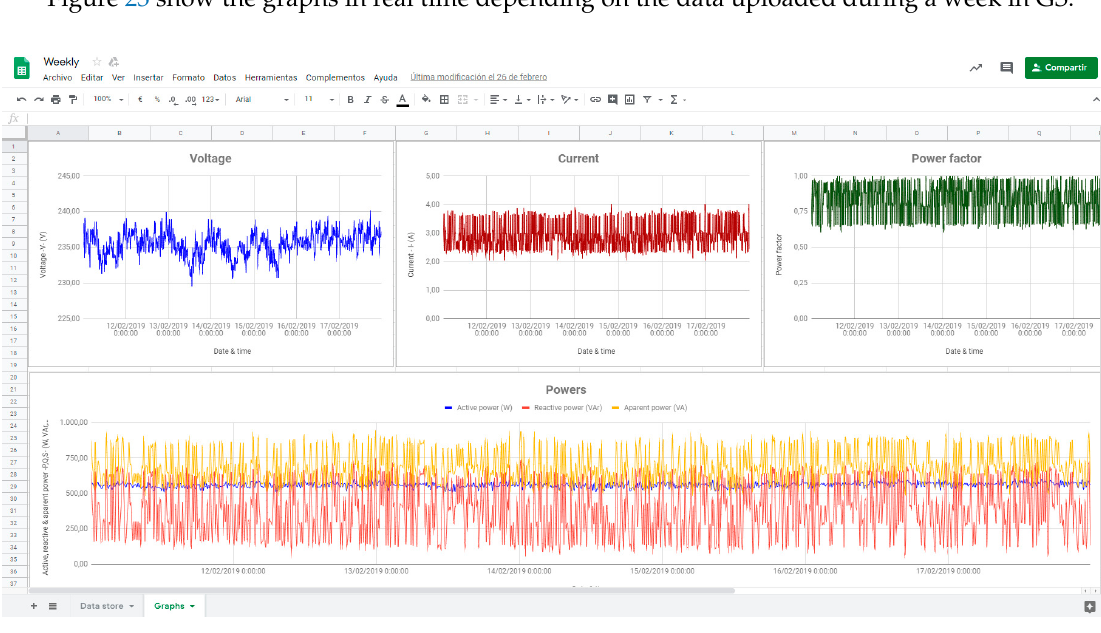
Figure 22. Difference between PF OBT and PF DES of daily.